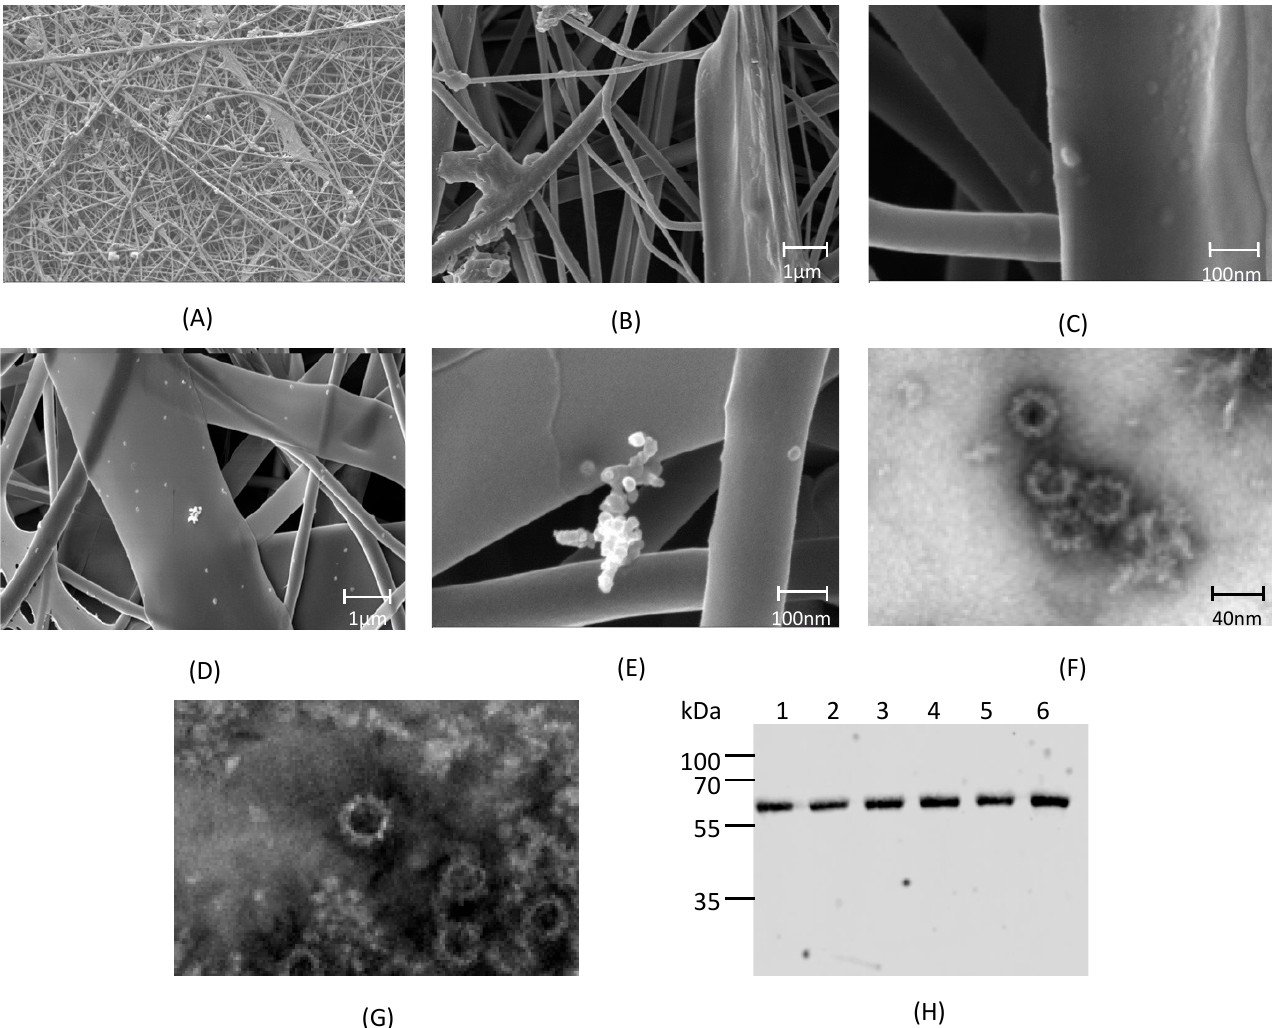
Figure 2. Incorporation and analysis of VLP in electrospun nanofibers. ( A ) Macrostructure of a nanofiber mat produced by electrospinning a 15% w / v polyvinylpyrrolidone (PVP) solution. ( B , C ) SEM of blank nanofiber microstructures. ( D , E ) SEM of RHDV VLP-loaded nanofiber microstructures. ( F , G ) RHDV-loaded nanofibers were dissolved and re-purified on a CsCl gradient, recovered material viewed by TEM. ( H ) Nanofiber loading uniformity. Lanes 1–6 represent randomly selected samples cut from the nanofiber mat and dissolved. An amount equivalent of 0.1 cm 2 nanofiber was run in each lane and VP60 levels compared by fluorescent western blot using an anti-RHDV VP60 antibody. The original western blot and relatively band intensities are shown in Supplementary Figure